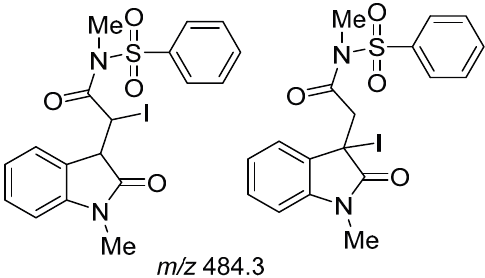
Figure 1. Putative structure for two major isomeric intermediates detected by ESI.